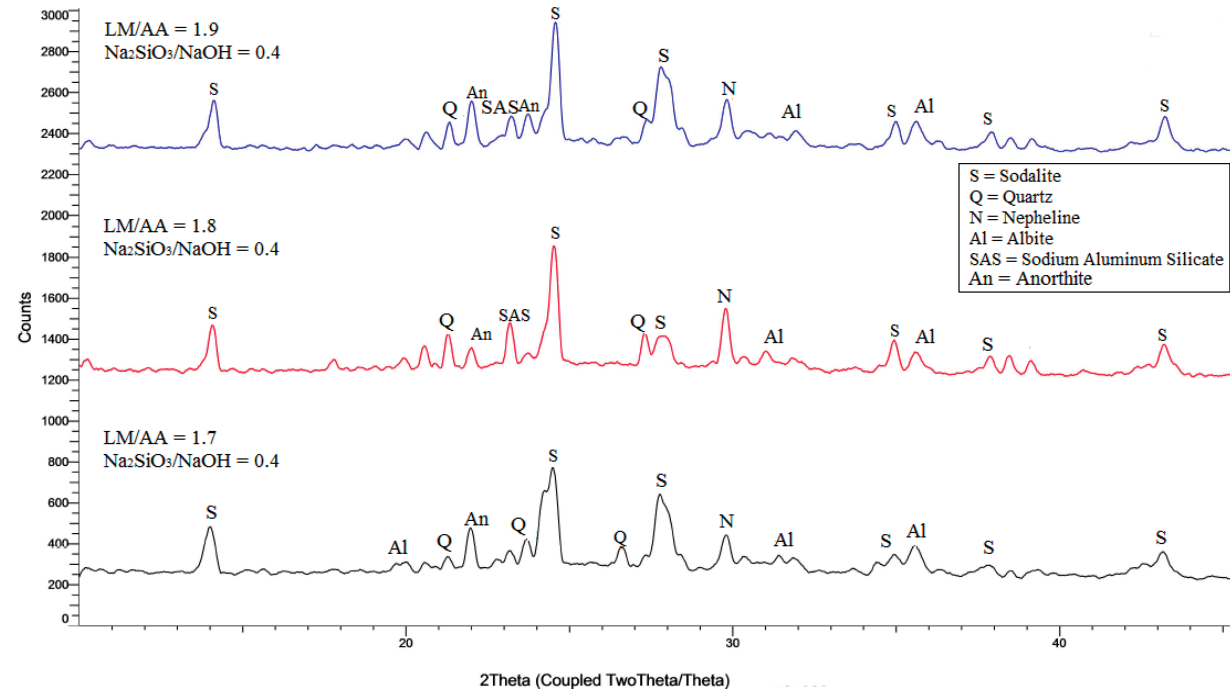
Figure 5. XRD pattern of ALGA produced at various LM/AA ratio and Na 2 SiO 3 /NaOH